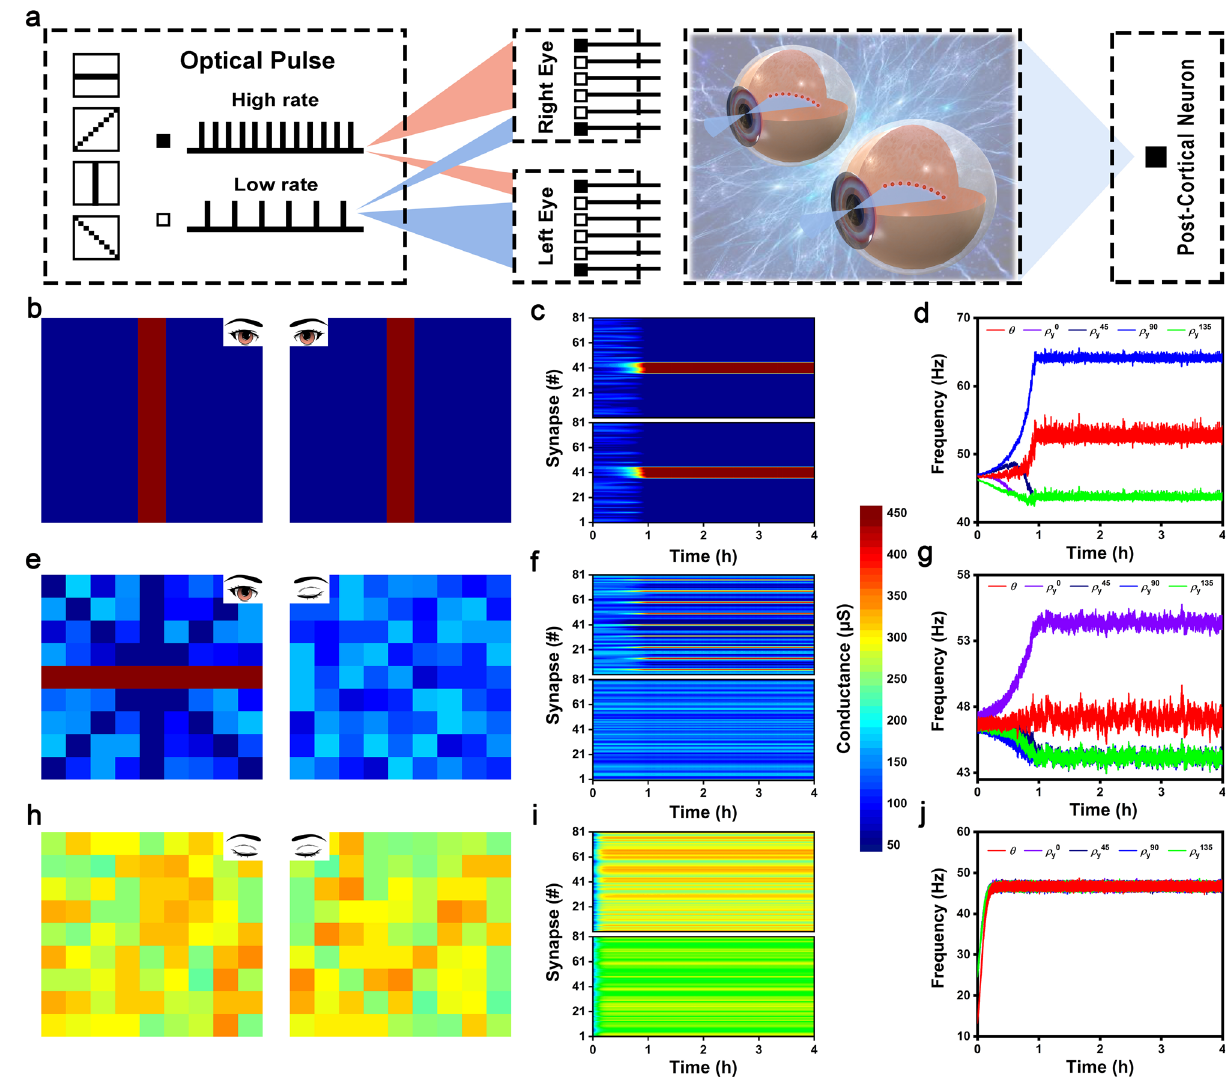
Fig. 5 | Simulated large-scale crossbar array for arti fi cial striate cortex with binocularity and orientation selectivity. a Schematic of SNN for the orientation selectivity simulation. b The fi nial color maps of 9×9 cortical synapse arrays in normally rearing condition of orientation selectivity simulation, including two arrays for left and right eyes. c The evolution of synaptic weights as a function of